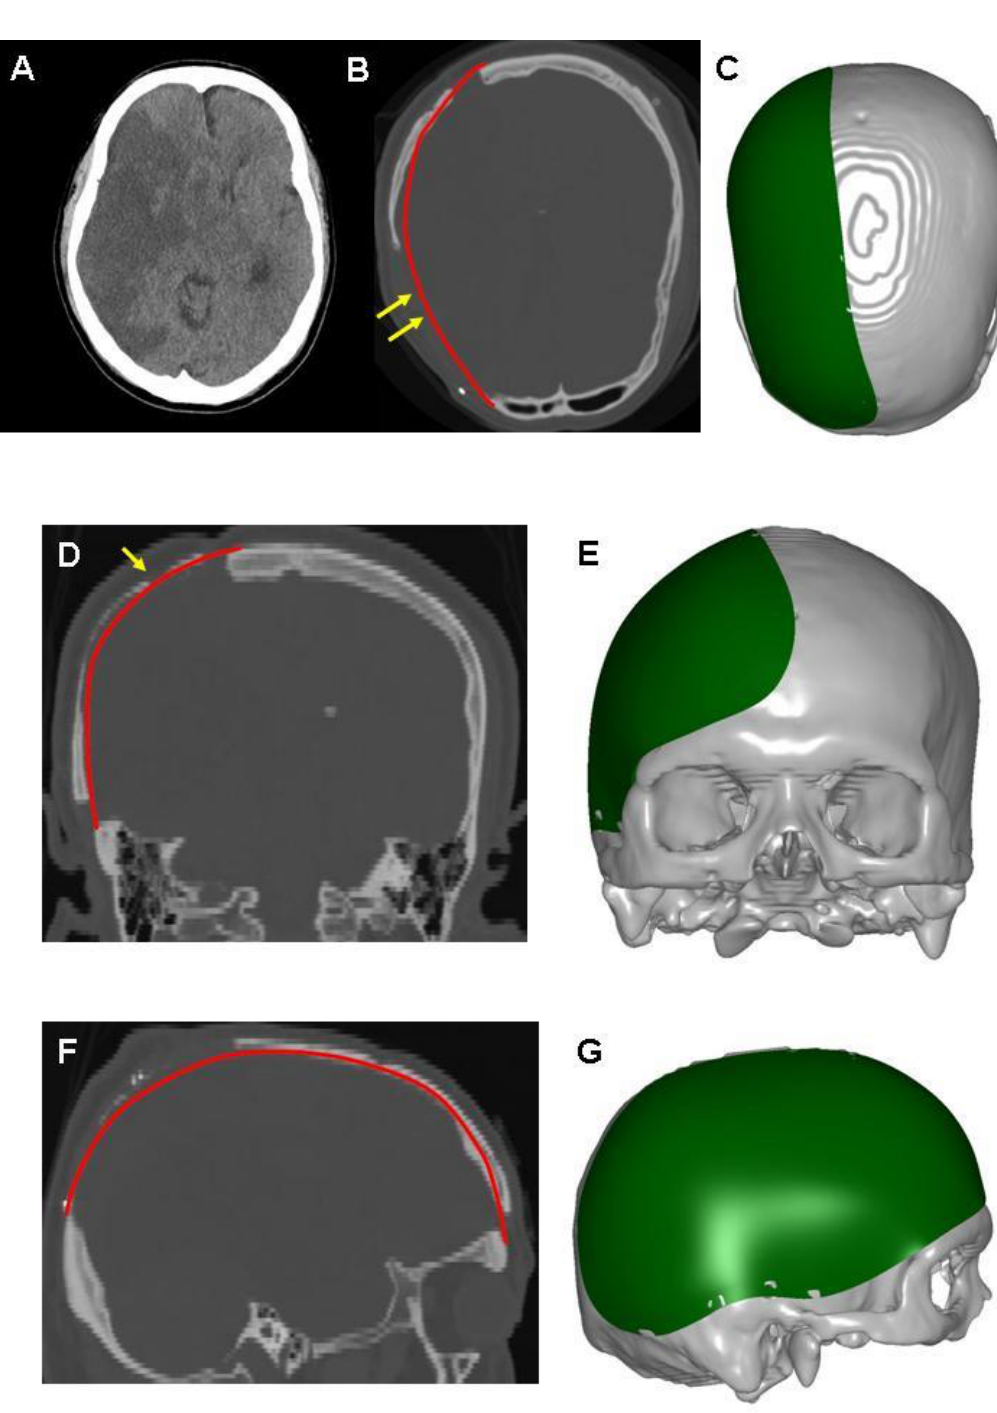
Figure 2. A 3-D CAD model for the skull defect reconstruction of case 1. ( A ) Initial computed tomography (CT) scan, revealing malignant in the left cerebral hemisphere with profound brain swelling, causing brainstem compromise. The patient received cranioplasty using autogenous bone graft. Resorption of autogenous bone has been shown with single arrows in ( D ). The 3-D CAD/CAM-fabricated implants will be made for surgery. Reconstructed contour of the skull defect as labeled in red, axial view in ( B ), coronal view in ( D ), and sagittal view in ( F ). Curvature of bony loss, double arrows in ( B ) can be compensated using newly reconstructed contour. Reconstructed 3-D models presented as the axial view in ( C ), coronal view in ( E ), and sagittal view in ( G ). The reconstructed artificial flap is labeled in green.